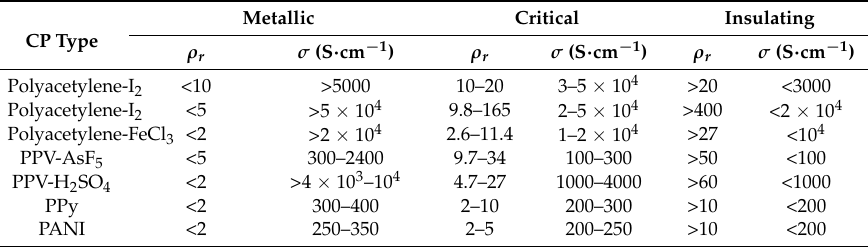
Table 4. The σ (300K) and ρ r = [ ρ ( 1.3K ) / ρ ( 300K )] values for several representative CPs in the metallic, critical, and insulating regimes